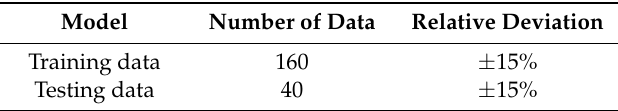
Figure 10. Performance of all measured and predicted database for the ANFIS-GA model.